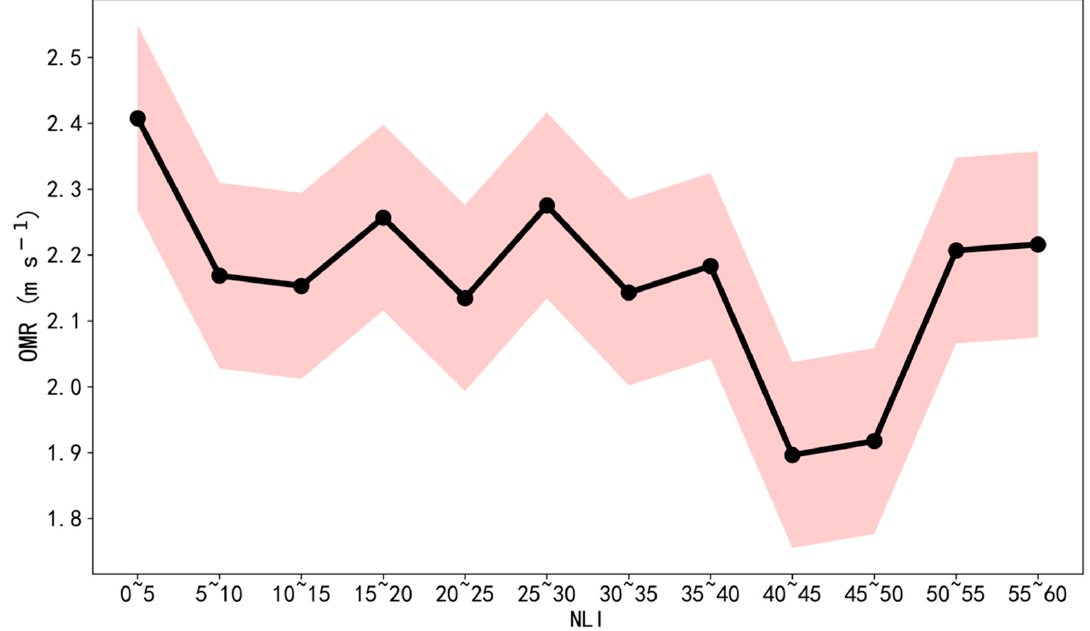
Figure 8. Variations of OMR (m s − 1 ) according to NLI, with the shadings denoting the standard deviations.